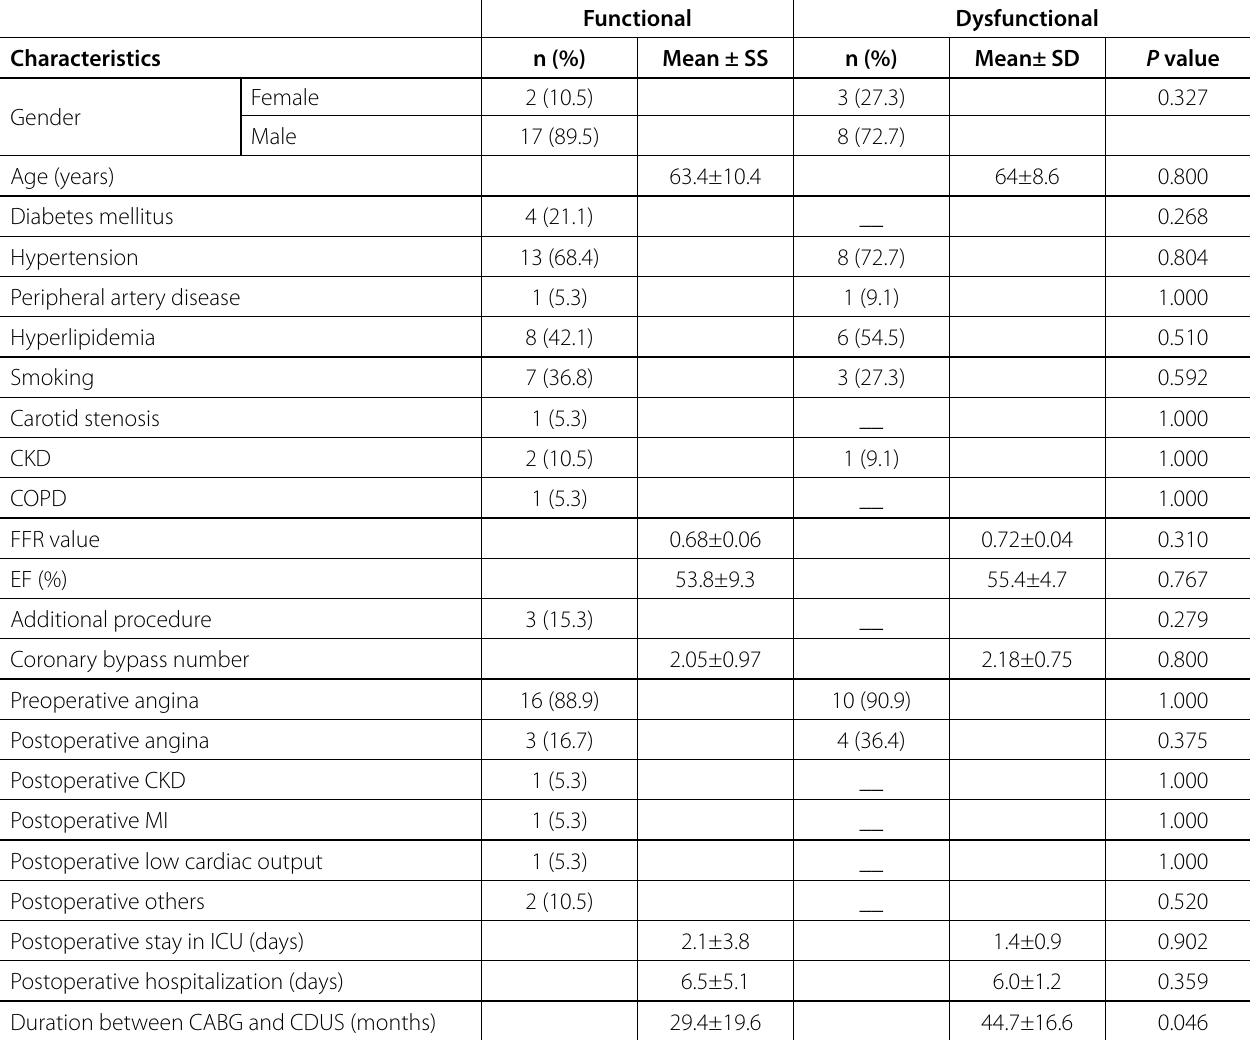
Table 3 . Comparison of demographic and clinical characteristics of patients with functional and dysfunctional ITAG on color CDUS. Functional